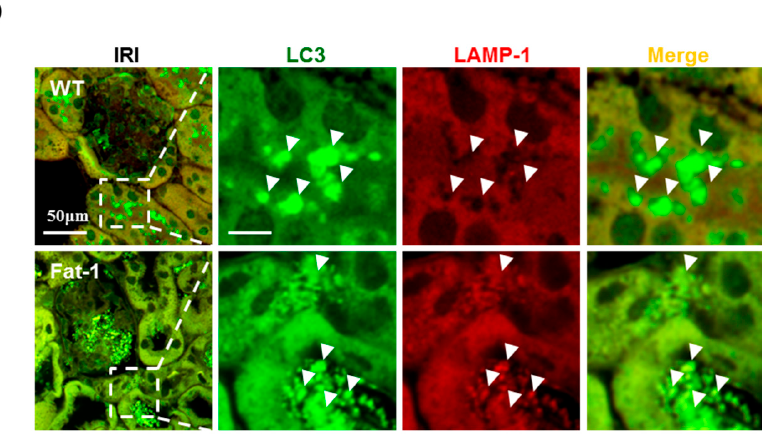
Figure 4. Autophagy activation in IR kidney. ω 3–Polyunsaturated fatty acids (PUFA) increased autophagy activation in fat-1 mice. ( A ) ω 3-PUFA increases LC3-II accumulation and the appearance of LC3-II punctate. Scale bar = 50 µ m; ( B ) The total RNA of tissue following individual experiments was isolated and subjected to real-time PCR. Transcripts of Beclin-1, Atg7, and LC3B were examined after optimization of PCR conditions. Relative mRNA ratios of each autophagy-related gene are described relative to levels of β -actin; ( C ) Tissue proteins were immunoblotted with anti-LC3-II, anti-cathepsin D, ATP6E, and anti-p62. Immunoblotting with β -actin was performed as a loading control. The right bar graph indicates the ratios of LC3-II, cathepsin D, ATP6E, and p62/ β -actin as determined by densitometry; and ( D ) Wild and transgenic fat-1 mice were analyzed by fluorescent staining with LC3-II and LAMP-1 to evaluate colocalization of LAMP1-positive lysosomes with LC3-II-labelled autophagosomes. White triangle indicate LC3-LAMP1 colocalized region. The colocalization of punctate LC3-II and LAMP 1 was assayed using confocal microscopy. Cell nucleus was stained with Hoechst (blue). Scale bar = 50 µ m. * p < 0.05 vs. WT-sham kidney, # p < 0.05 vs. fat-1-sham kidney, ** p < 0.05 vs. WT-IR kidney. Bar represents mean ± S.D.